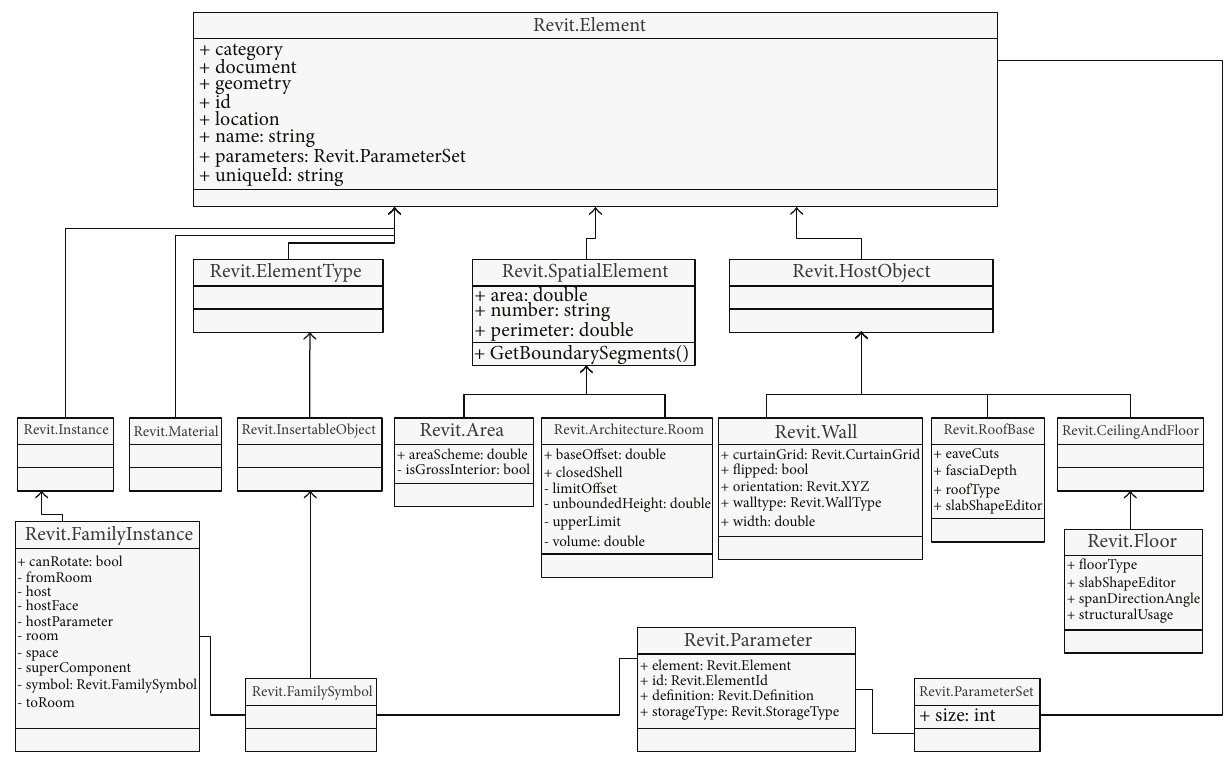
Figure 4: Class diagram of the Revit model